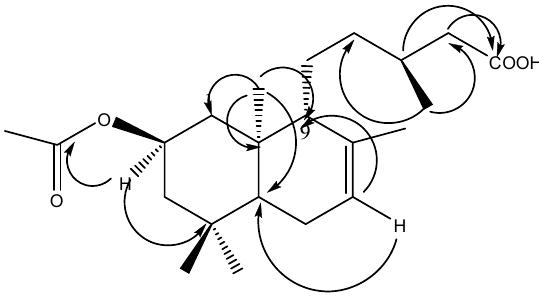
Figure 2. Key HMBC correlations of compound 1 .